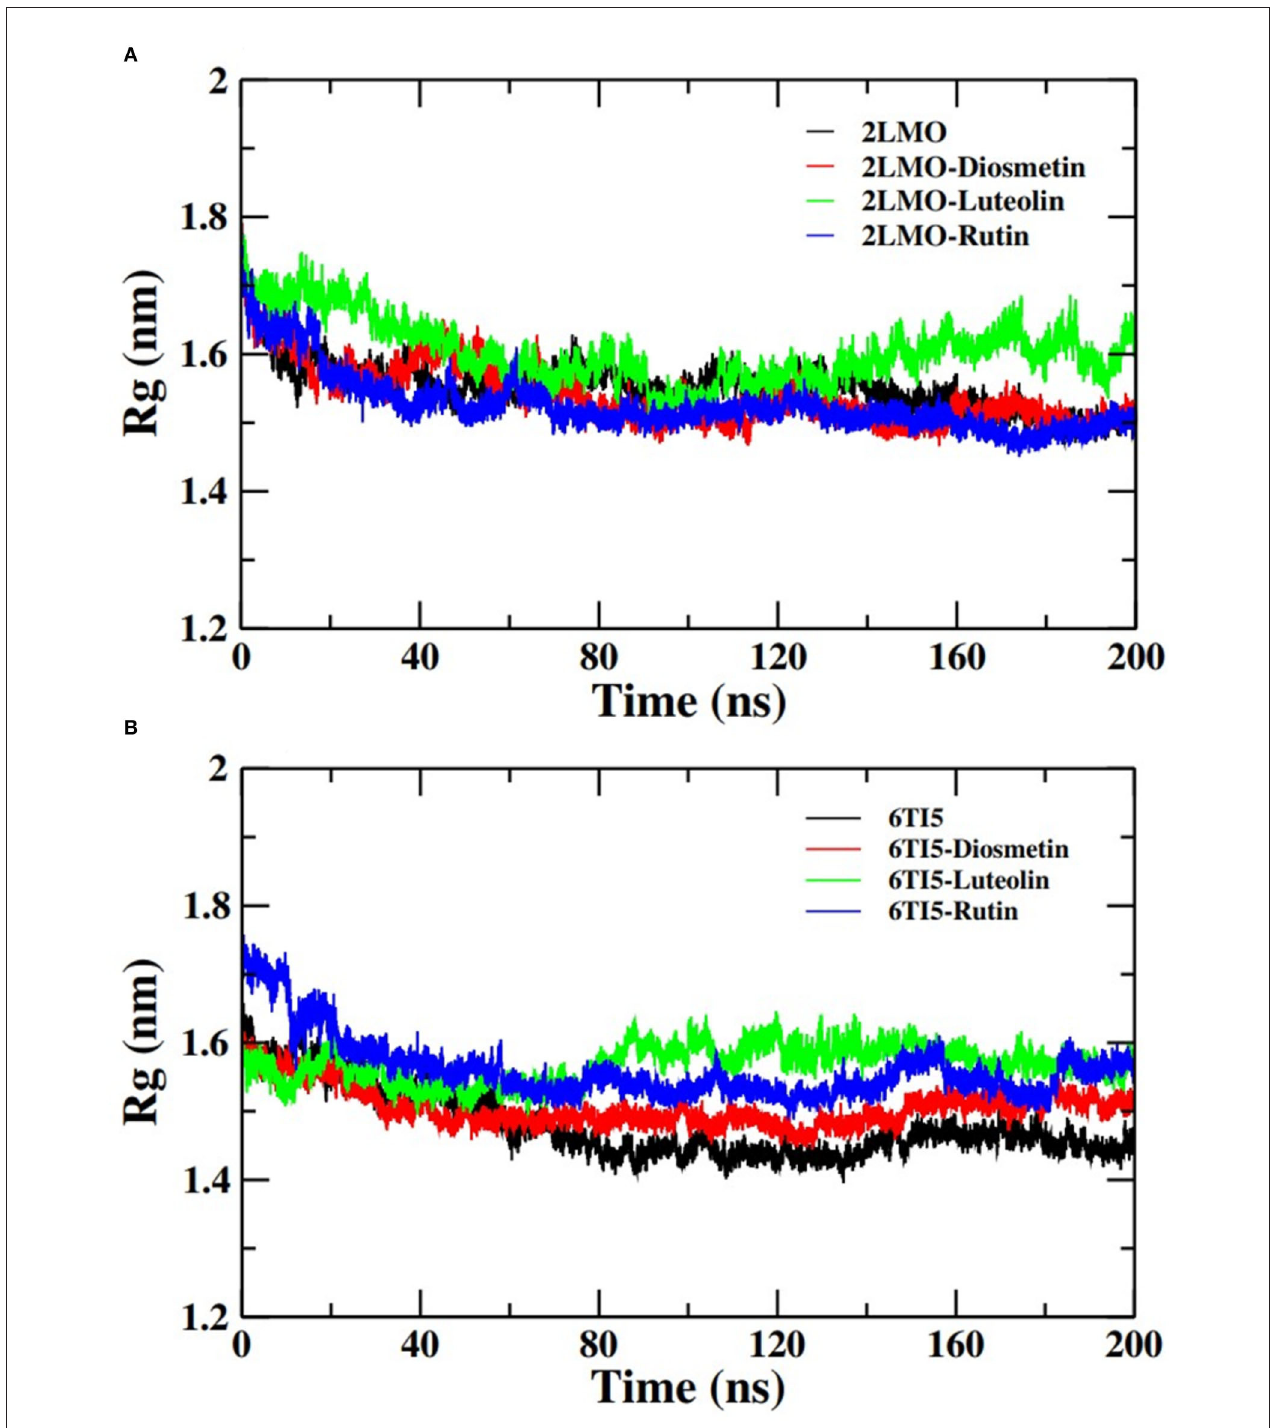
FIGURE 4 | Radius of gyration (Rg) of backbone atoms of (A) 2LMO and its complexes with Diosmetin, Luteolin and Rutin and (B) 6TI5 and its complexes with Diosmetin, Luteolin and Rutin over the course of 200 ns of simulation time.